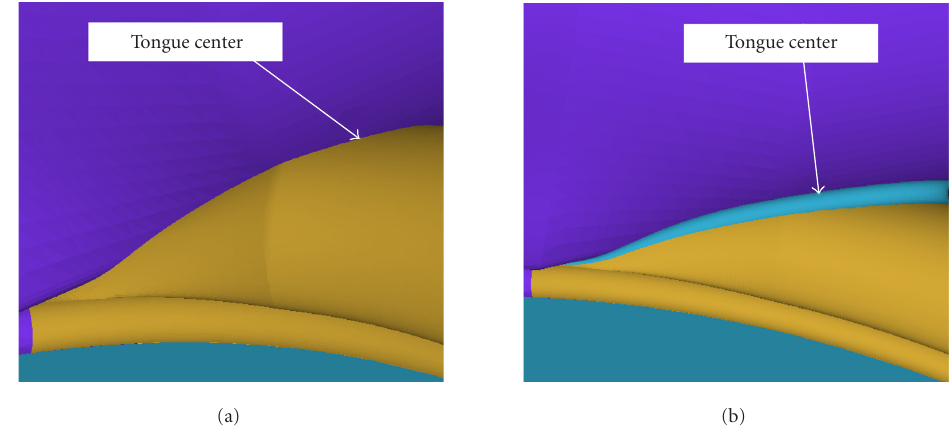
Figure 5: The tongue structures, showing a variation in the leading edge. (a) Sharp tongue, r/b = 0 (knife-edge). (b) Round tongue, r/b = 0 . 3.